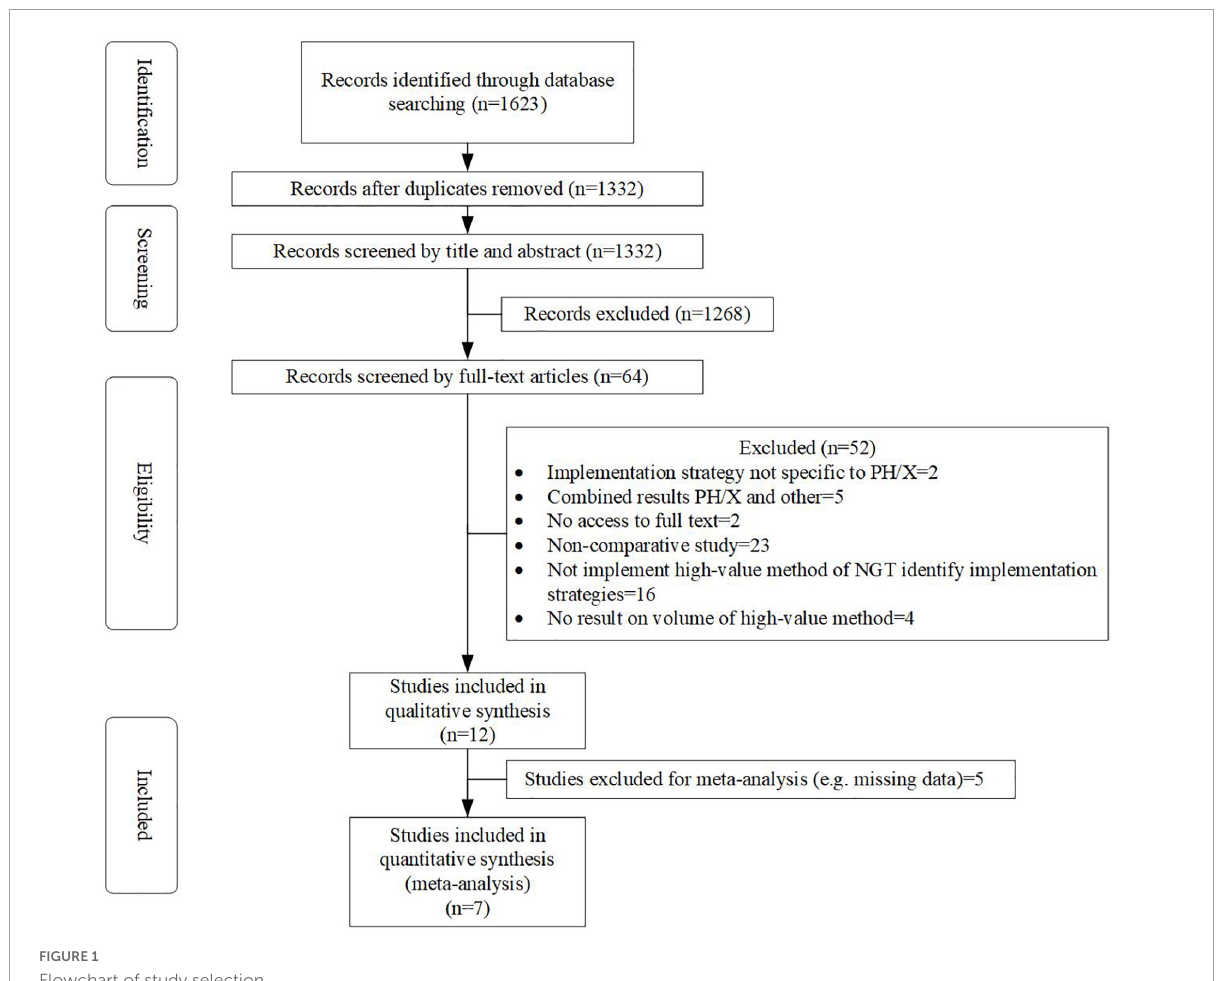
FIGURE1 Flowchart of study selection.